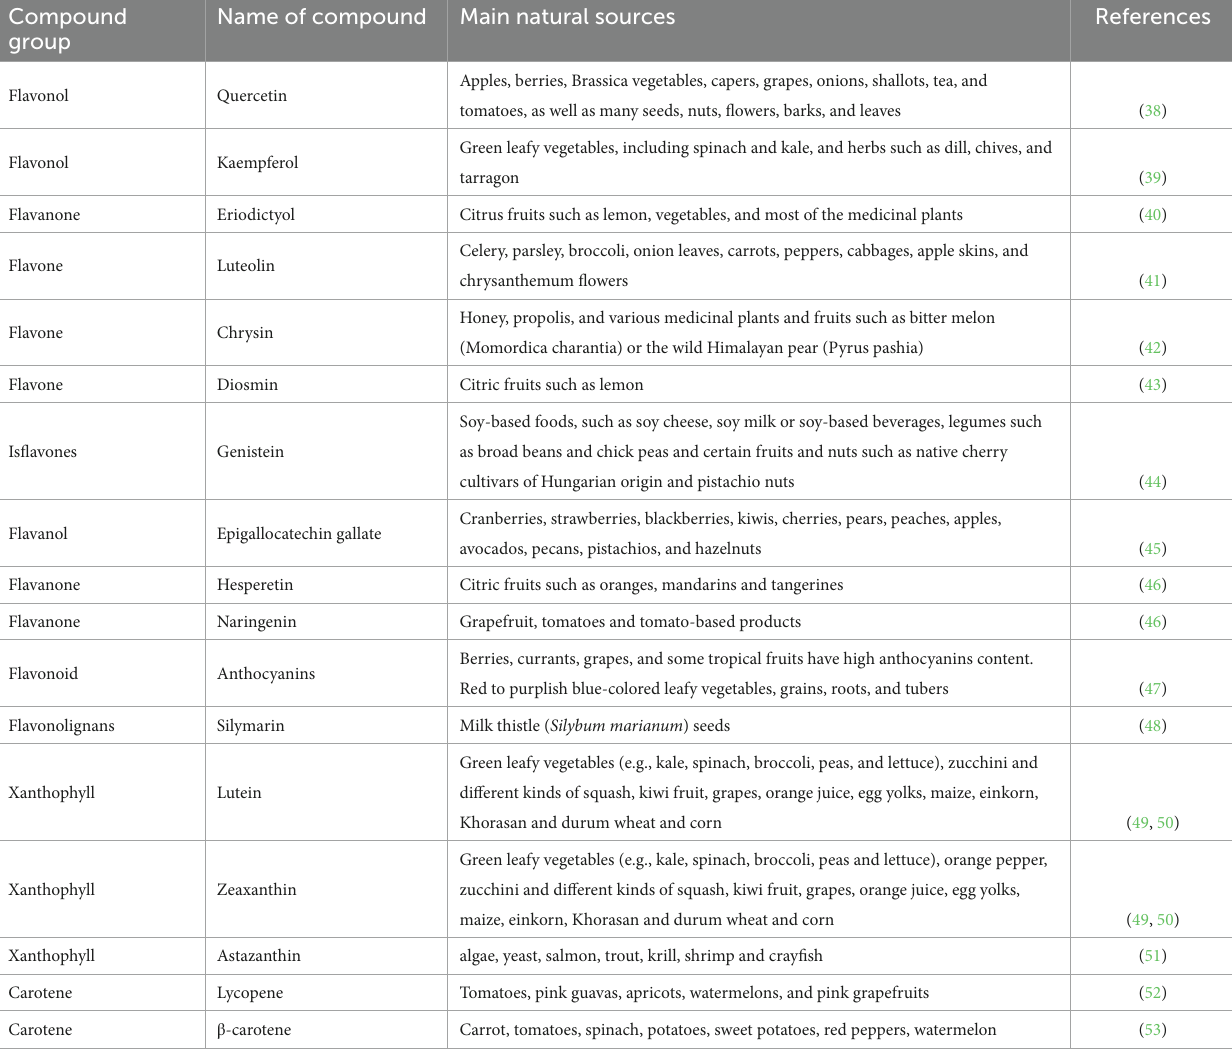
TABLE 1 Major sources of flavonoids and carotenoids used in the treatment of diabetes and its complications. Compound Name of compound Main natural group